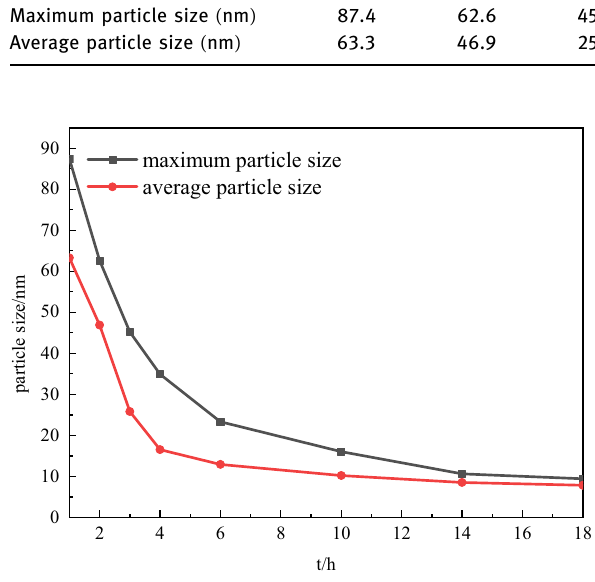
Table 2: Particle size of CdS/TiO 2 composite photocatalysts at di ff erent ball milling time Ball milling time ( h )